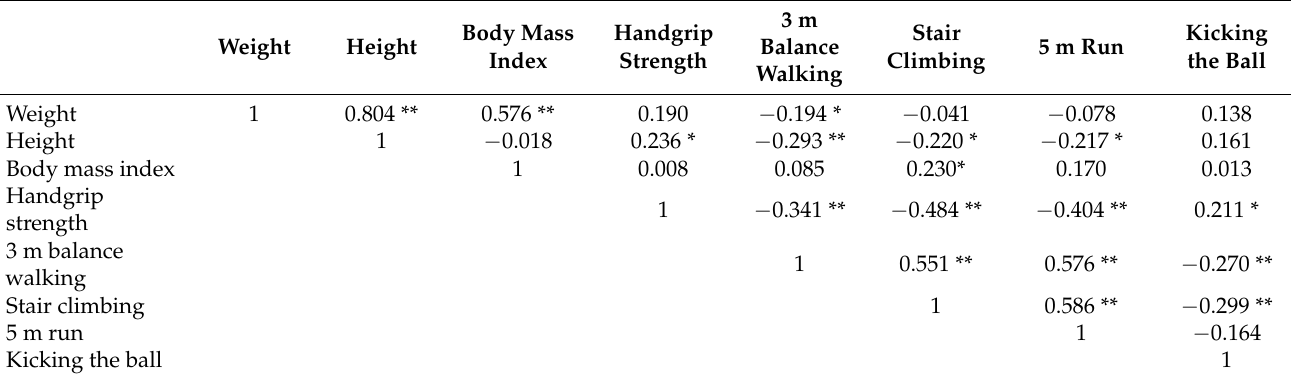
Figure 3. Scatterplot of the test and retest Handgrip Strength ( A ), 3 m balance walking ( B ), Stair climbing ( C ), 5 m run ( D ), Kicking the ball ( E ). Table 3. Pearson correlation between the test